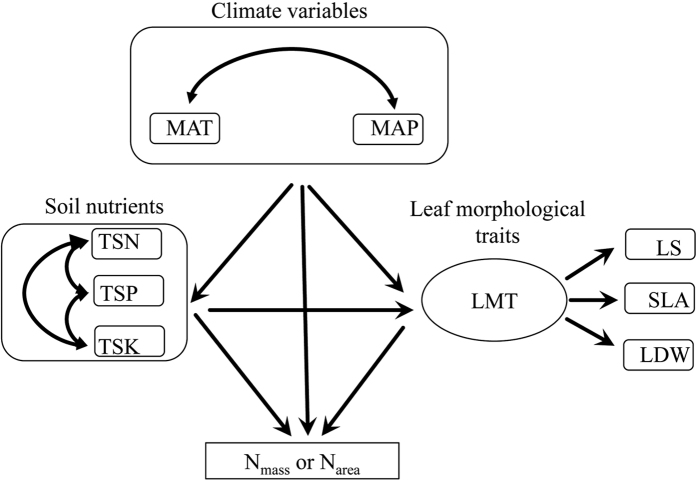
Illustration of all potential interaction pathways for leaf nitrogen in the study system.MAT, mean annual temperature; MAP, mean annual precipitation; TSN, total soil nitrogen; TSK, total soil potassium; TSP, total soil phosphorus; SLA, specific leaf area; LS, leaf size; LDW, leaf dry weight; LMT, leaf morphological traits; Nmass, leaf nitrogen content per unit mass; Narea, leaf nitrogen content per unit area.